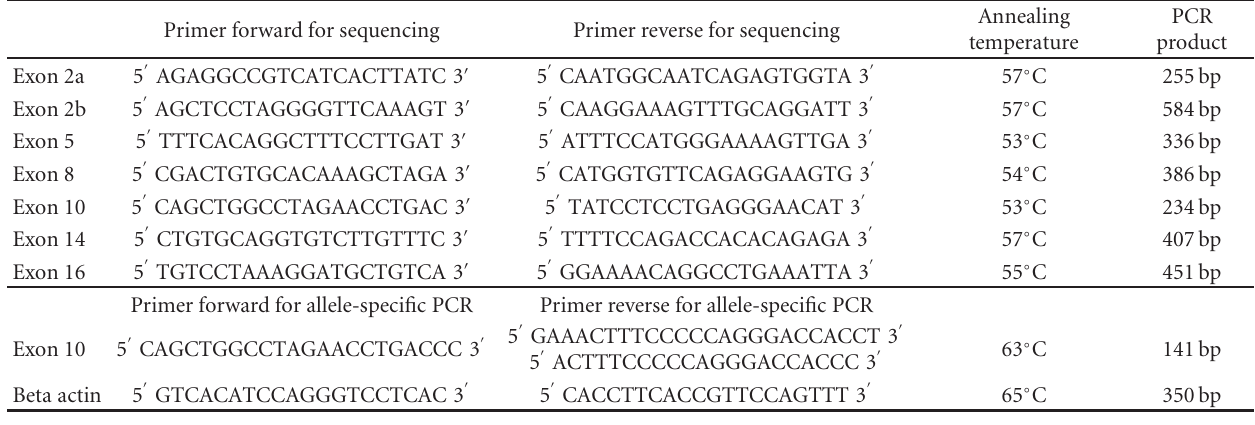
Table 1: Oligonucleotides sequences.